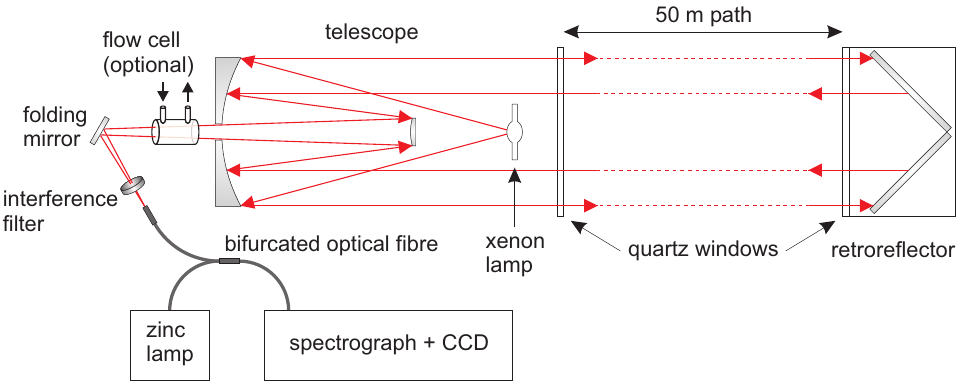
Fig. 2. Schematic overview of the RIVM DOAS design. The light of a xenon lamp is directed by the combined sender/receiver telescope to a corner cube retroreflector, placed at a distance of 50m. The light is reflected back to the telescope by the retroreflector. With the use of two mirrors the light is focussed onto an optical fiber that couples the light into the spectrograph followed by a CCD detector, after passing through an interference filter. The zinc lamp with its distinctive emission peak around 213.9nm is used for calibrating the wavelength mapping onto the CCD. The optional flow cell is used to supply known amounts of traces gases for calibration measurements.